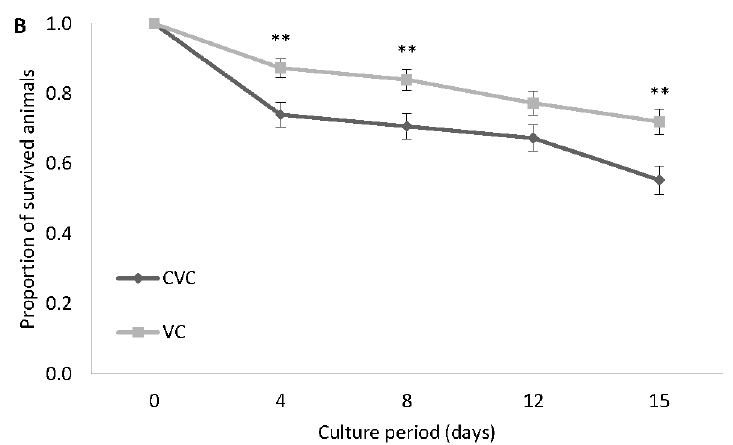
Figure 2. Experiment 1. Proportion of surviving Artemia cultured in Lake Bunyampaka saline water at 30 g L − 1 for 15 days; GSL ( A ) and VC ( B ). Values are presented as means ± SE. ( n = 3), * p < 0.05, ** p < 0.01, *** p < 0.001, **** p < 0.0001, ***** p < 0.00001, ****** p < 0.000001 vs. the corresponding control group. GSL: Great Salt Lake, CGSL: Control for Great Salt Lake, VC: Vinh Chau, CVC: Control for Vinh Chau.